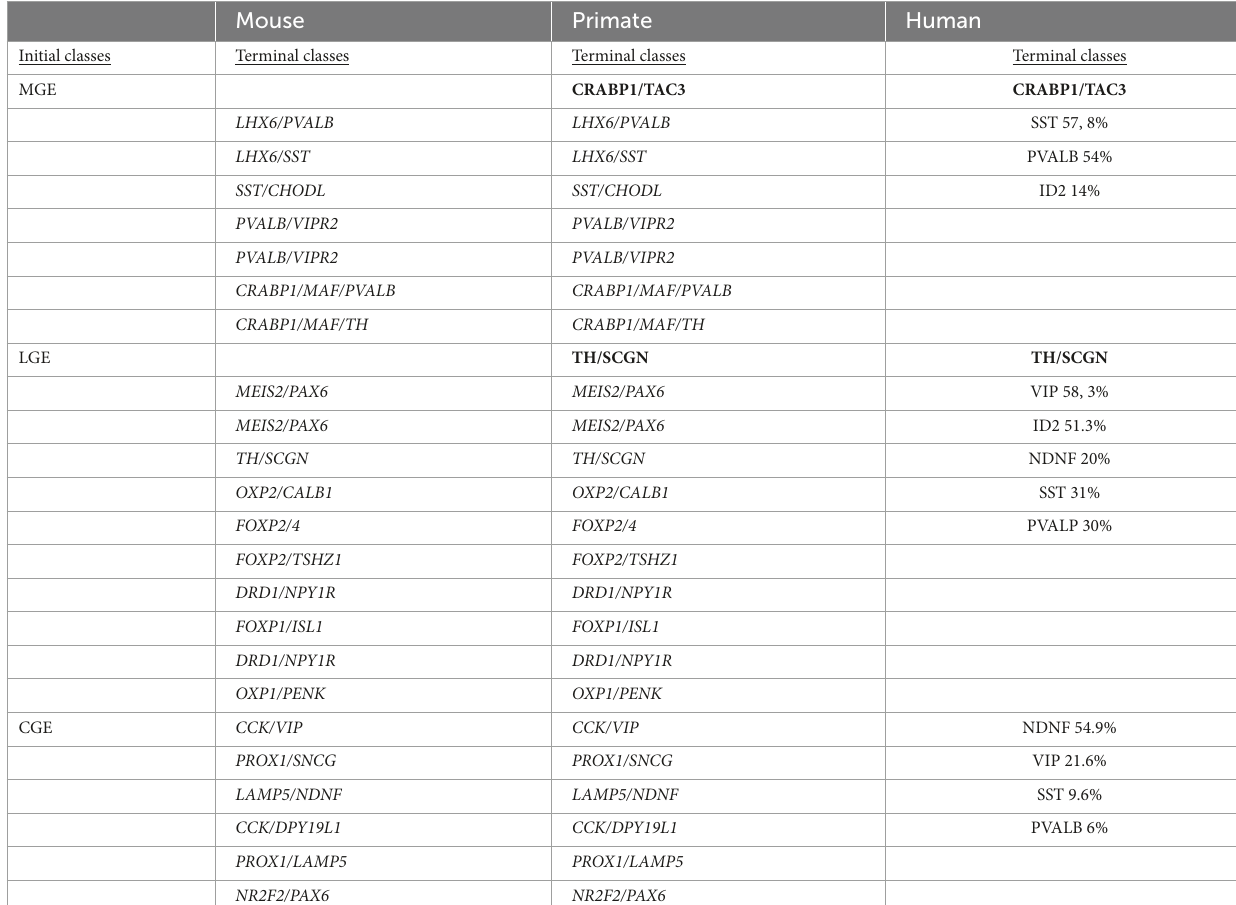
TABLE 3 Interneurons origin comparison between mouse, primate, and human